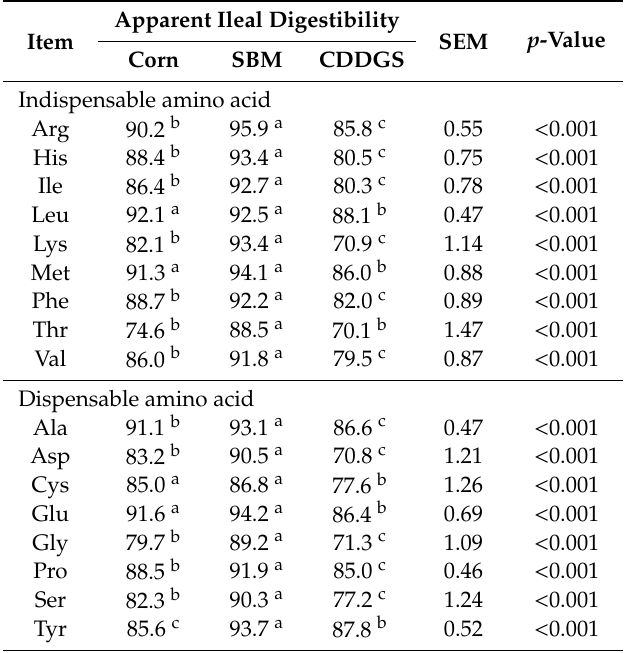
Table 5. Apparent ileal amino acid digestibility (%) of broilers fed corn-, SBM-, and CDDGS-based diets. Apparent Ileal Item